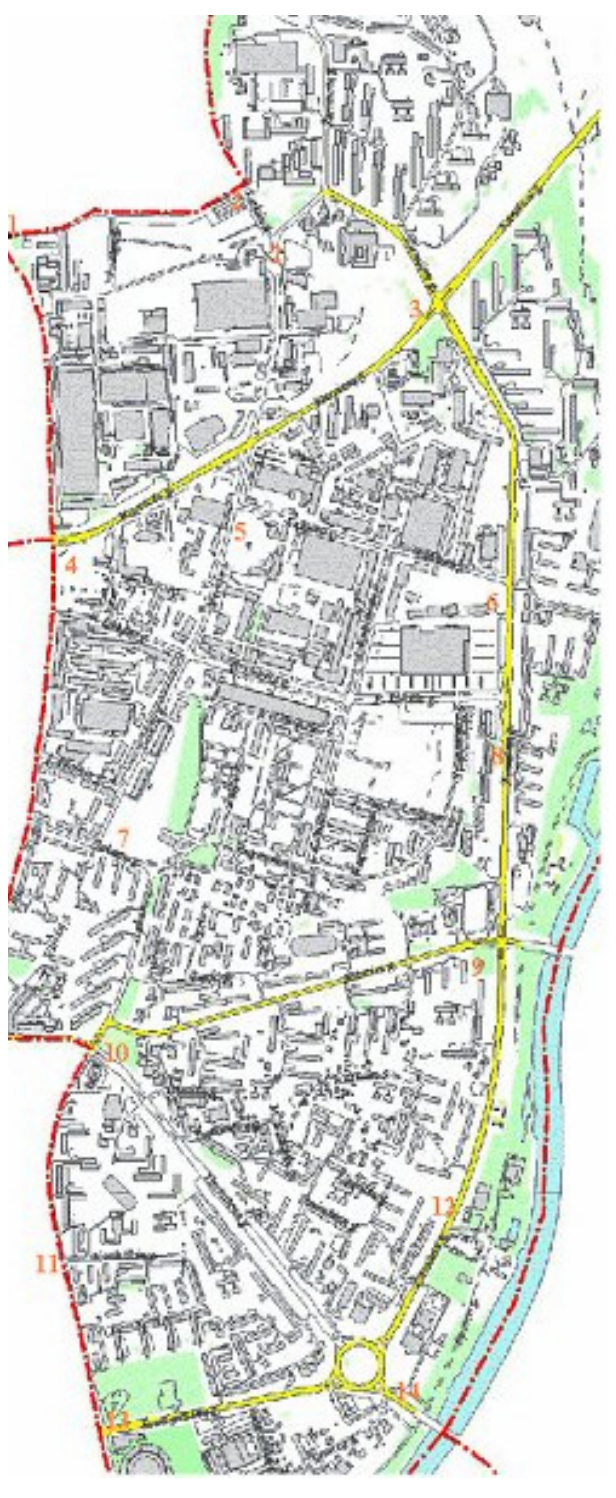
Fig. 3. The map of district